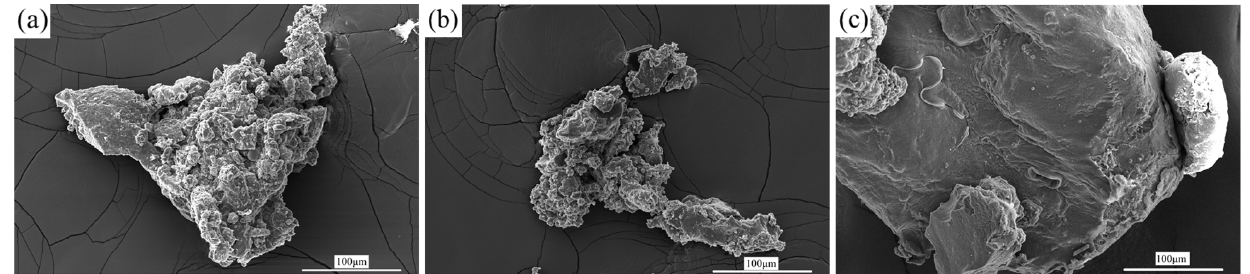
Figure 2. SEM images of ( a ) GTR. ( b ) Extracted GTR from PLA/GTR without DCP. ( c ) Extracted GTR from PLA/GTR with DCP.